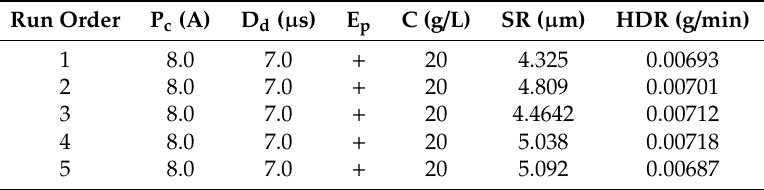
Table 9. Confirmation test results at optimized input parameters.